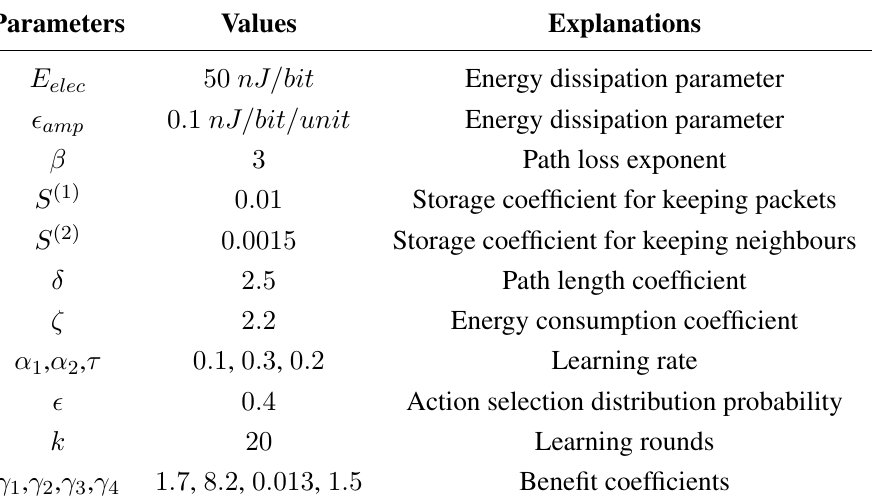
Table 1. Parameter settings.